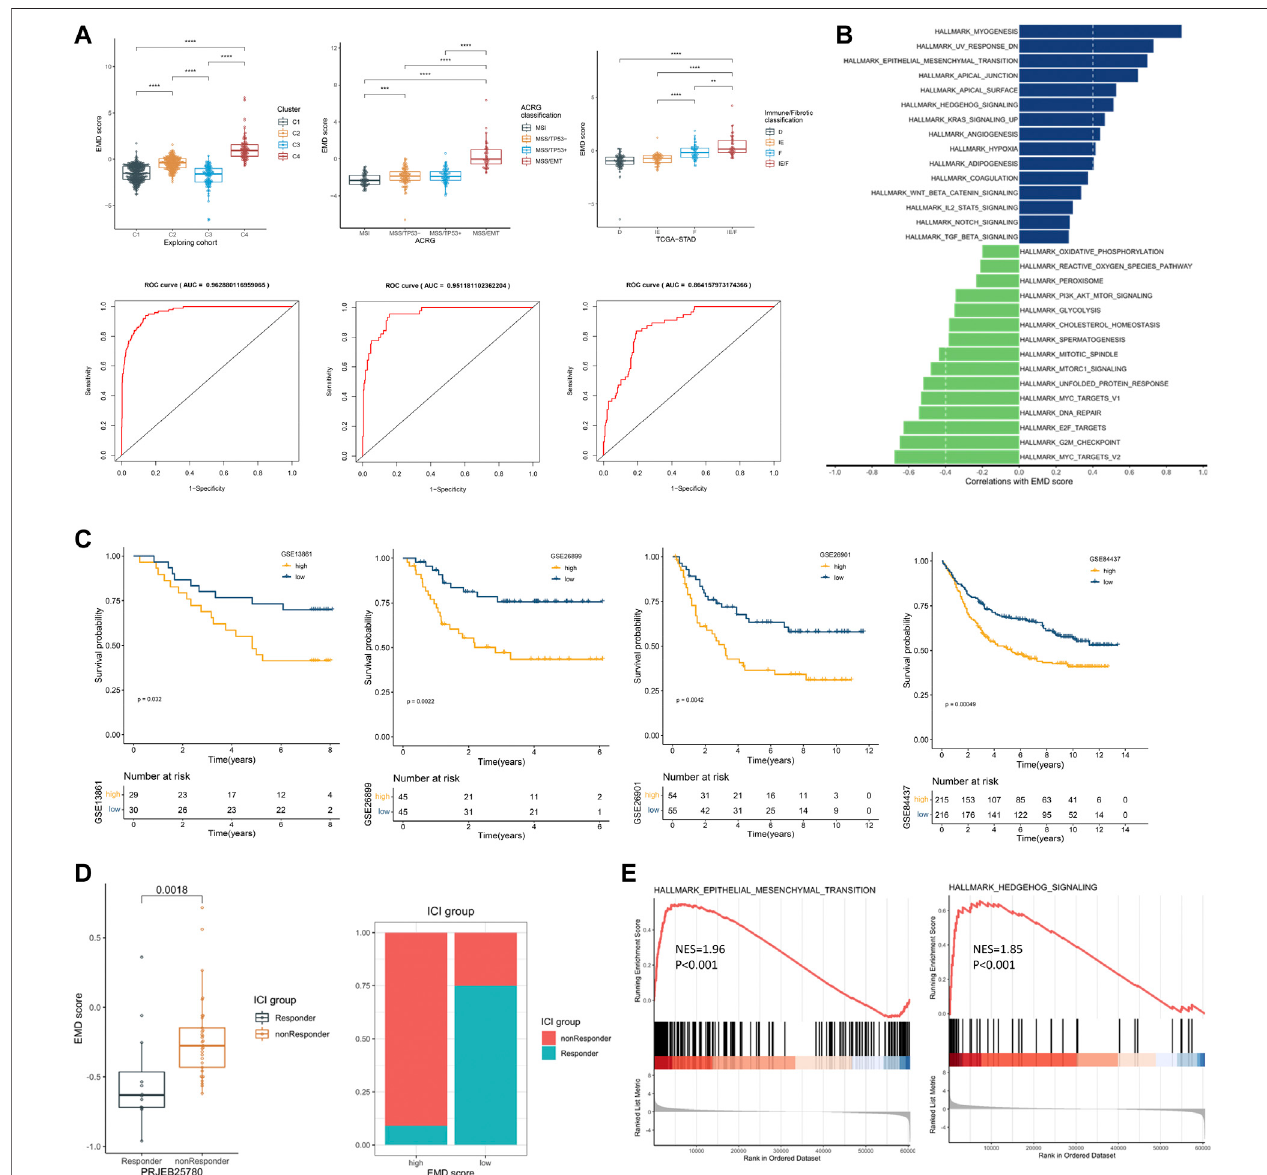
FIGURE7| RecognizingpatientswithEMDcharacteristics using theEMD score. (A) DifferentialEMD score ofsubtypes inthree classi fi cation proposals.The ROC below showed the performance of the EMD score in recognizing the EMD, MSS/EMT, and IE/F subtype in the corresponding cohort. (B) Hallmark pathways correlated with the EMD score in the validation set. (C) Kaplan – Meier curves showed the different overall survival between the high and low EMD groups in the validation set. PatientswereseparatedintohighandlowgroupsaccordingtothemedianEMDscoreofeachcohort. (D)